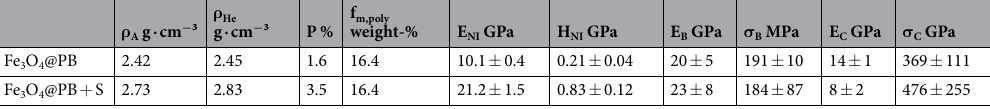
Table 1. Summary of physical properties of the Fe 3 O 4 /PB nanocomposites. ρ A : Archimedian density, ρ He : He-pycnometric density, f m,poly : mass fraction of polymer, E: elastic modulus measured by nanoindentation (NI), microbending (B) and microcompression (C) and σ : fracture strength of microbending (B) and microcompression